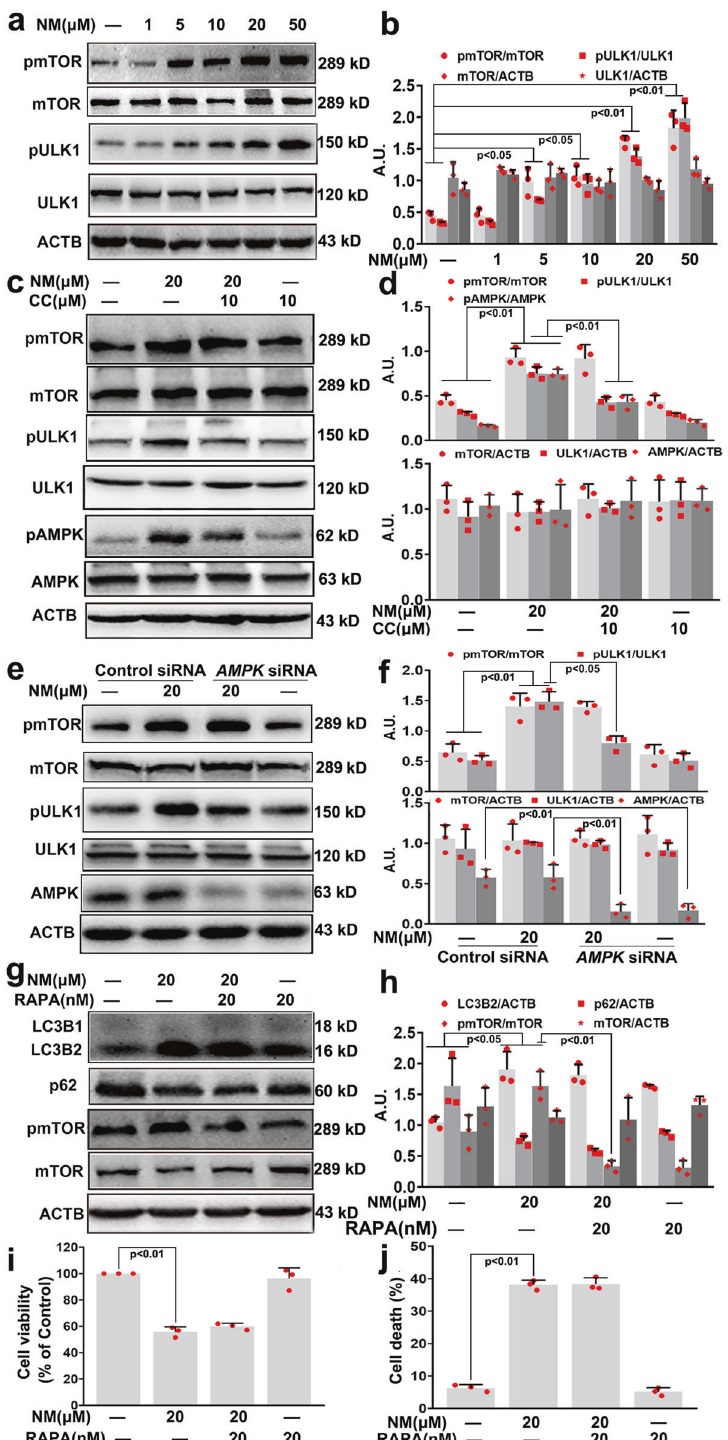
Fig. 5 NM-activated ULK1 and mTOR in keratinocytes. a Cells were treated with NM at a series of concentrations (1, 5, 10, 20, and 50 µM) for 24 h. The expression of mTOR, pmTOR, ULK1, and pULK1 was measured by western blotting. b The bar graphs show the quanti fi cation of endogenous pmTOR and pULK1. c Cells were pretreated with CC (10 µM) for 1 h followed by exposure to NM (20 µM) for an additional 24 h. Total cell lysates were immunoblotted with anti-mTOR, anti-pmTOR, anti-ULK1, anti-pULK1, anti-pAMPK, anti-AMPK, and anti-ACTB antibodies. d The bar graph shows the quanti fi cation of the indicated proteins. e AMPK was knocked down by AMPK siRNA as described in “ Materials and methods ” . At 24-h post-transfection, the cells were treated with NM (20 µM) for 24 h. Cells were collected and lysed, then western blot analysis was performed. f The bar graphs show the quanti fi cation of the indicated proteins. g Cells were pretreated with RAPA (20 nM) for 1 h followed by exposure to NM (20 µM) for an additional 24 h. Total cell lysates were immunoblotted with anti-mTOR, anti-pmTOR, anti-LC3, anti-p62, and anti-ACTB antibodies. h The bar graph shows the quanti fi cation of the indicated proteins. i Cell viability was detected by a CCK-8 detection kit. j Cell death was measured with PI staining by fl ow cytometry. Values are expressed as the means ± SD ( n = 3); A.U. arbitrary